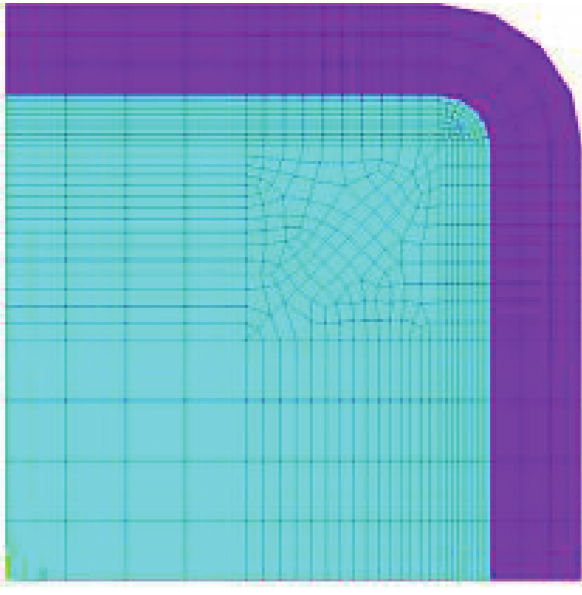
Figure 2: 2D finite-element model.